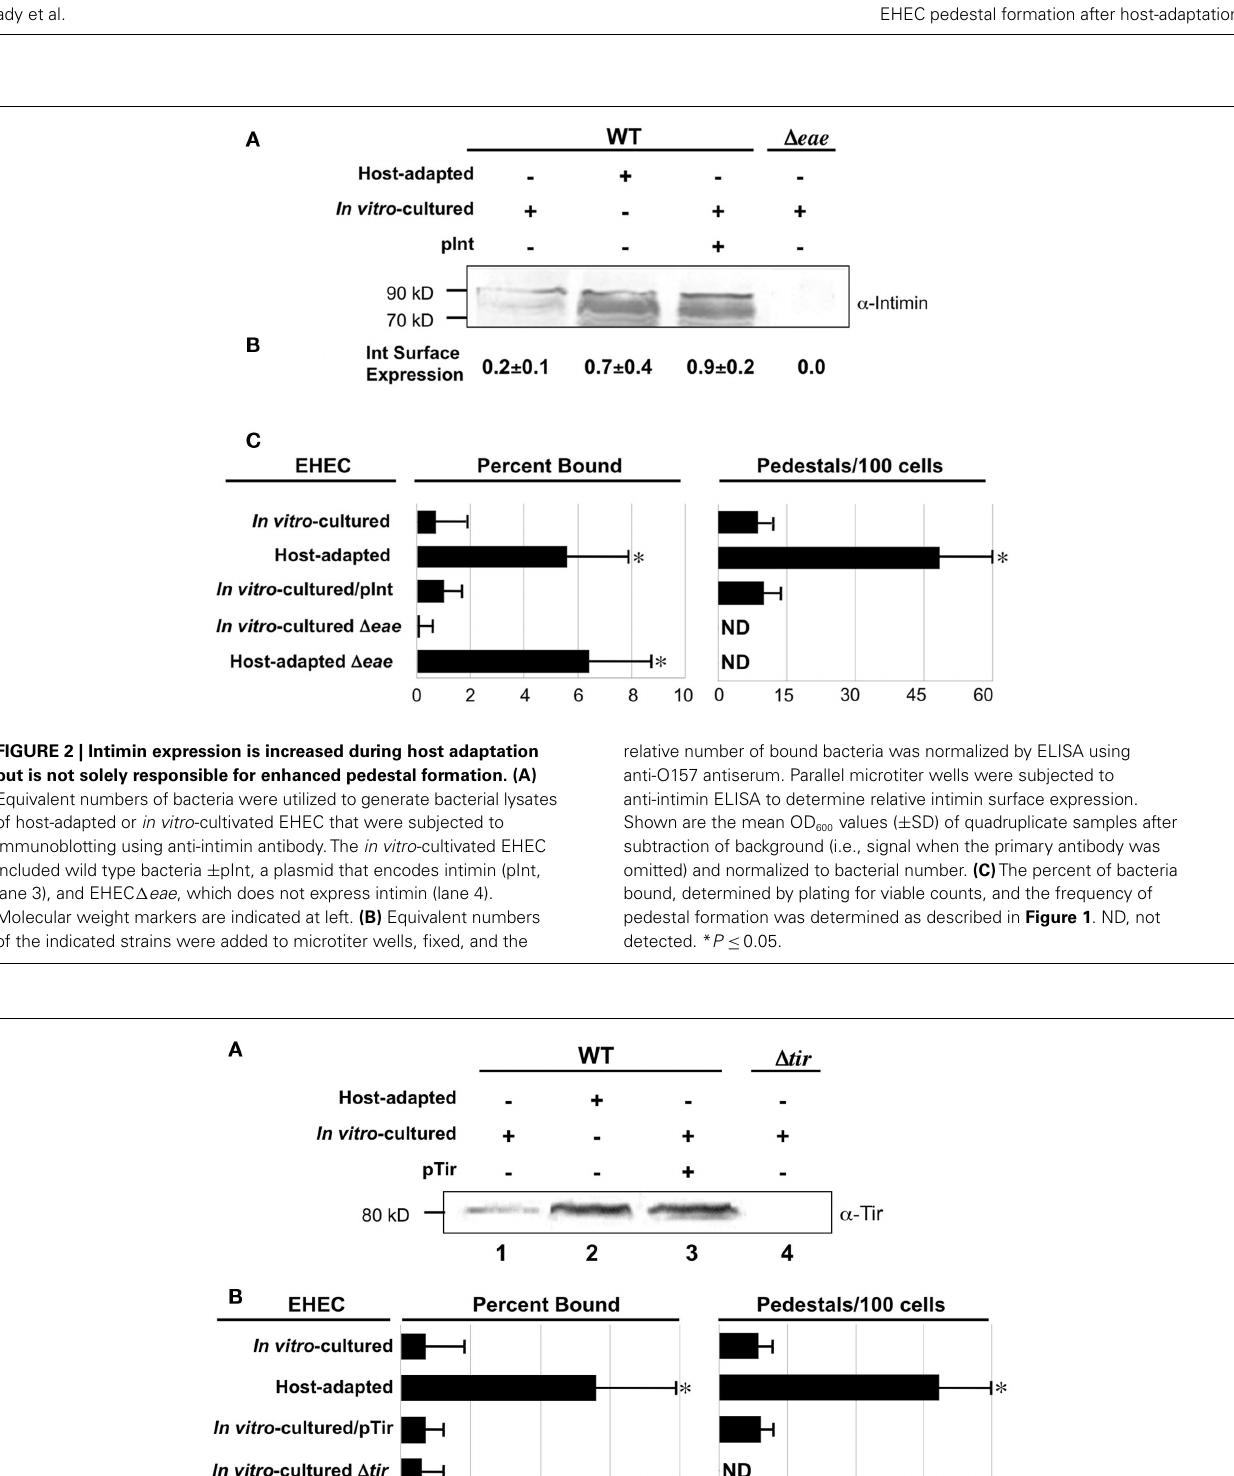
in vitro -cultivated EHEC included wild type bacteria ± pTir a plasmid that encodesTir (pTir, lane 3), and EHEC Δ tir (lane 4). Molecular weight is indicated at left. (B) Percent bacteria bound and the frequency of pedestal formation was determined as described in Figure 1 . ND, not detected.* P ≤